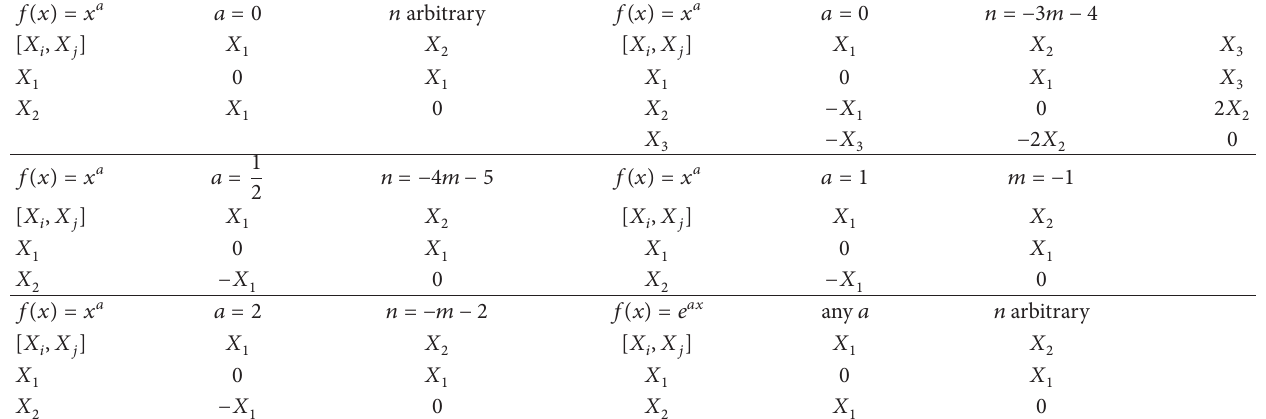
Table 10: Lie bracket of the admitted symmetry algebra for 𝑚 ̸=𝑛, 𝑛 ̸= − 1 and various 𝑓(𝑥) .